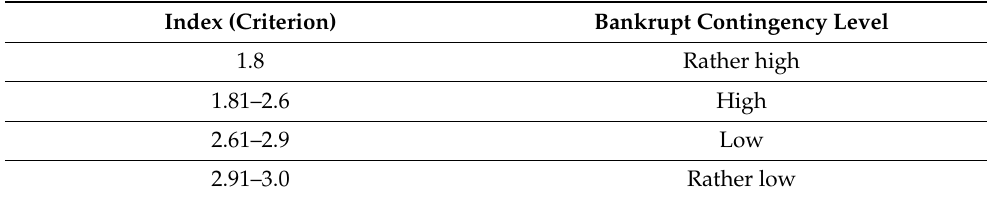
Table 3. Altman’s model approbation-based scale for determining (bankrupt contingency) an enter- prise’s state.